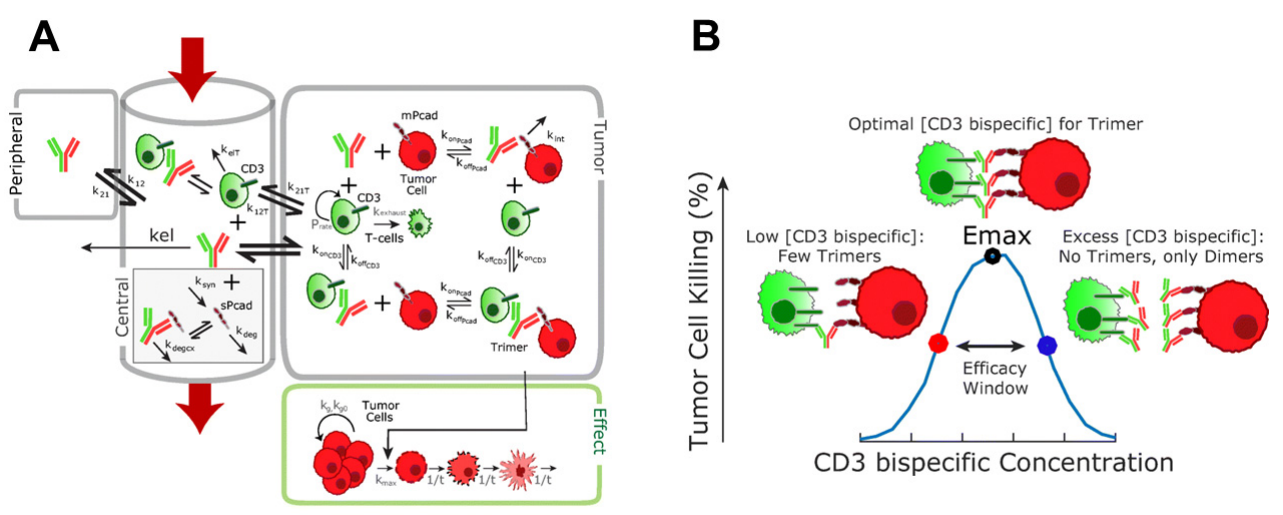
Figure 5. ( A ). QSP model for PF-06671008, bispecific anti-CD3/P-cadherin antibody. ( B ). Schematic of the bell-shaped tumor-cell-killing activity based on the concentration of trimer. Figure was repro- duced from [184].